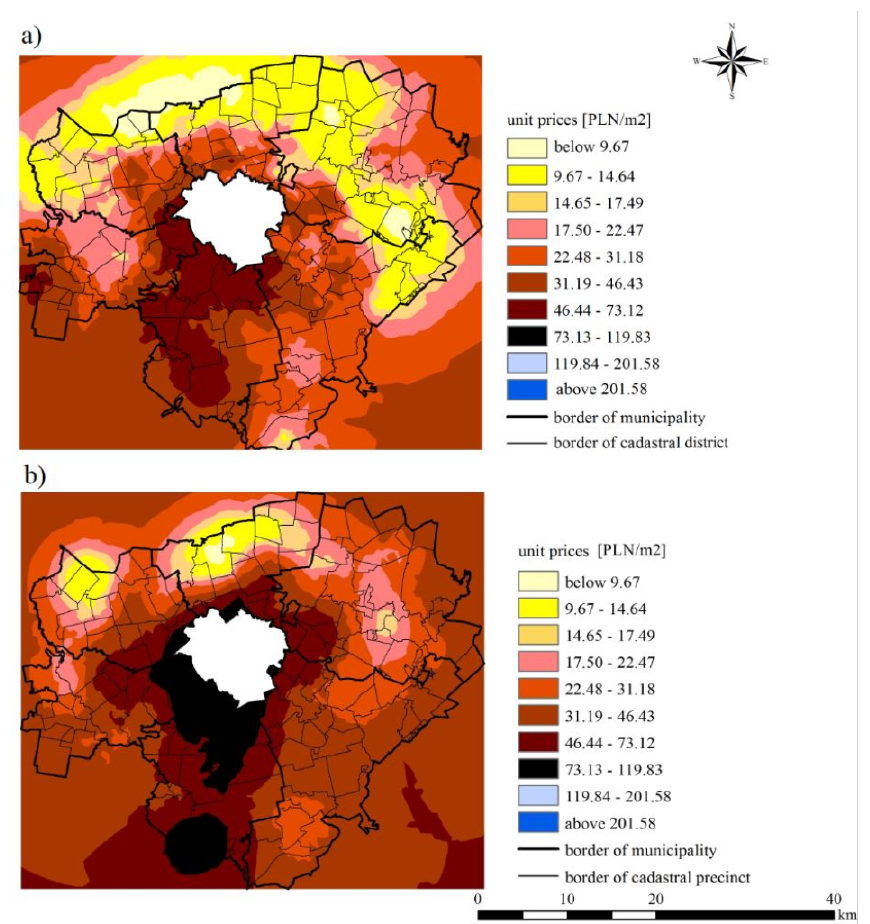
Figure 5. Interpolation of the unit prices of construction plots in the Olsztyn FUA in 2007 ( a ) and 2018 ( b ). Source: Own elaboration based on the Register of Real Estate Prices and Values kept by the County Center for Geodetic Documentation and Maps in Olsztyn.